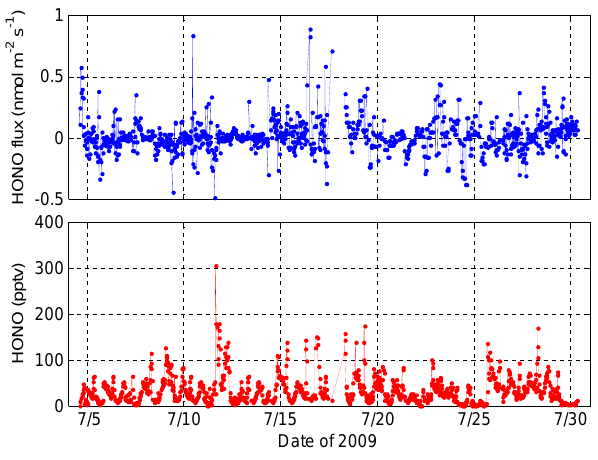
Figure 5. Time series of HONO flux (top) and HONO concentration (bottom) observed during BEARPEX 2009.